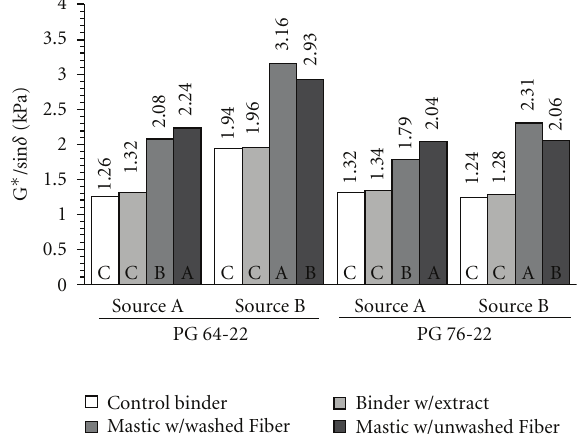
Figure 4: Phase angle ( δ ) results from dynamic the shear rheometer (DSR). The test temperature was 64 ◦ C for the PG 64–22 binders and 76 ◦ C for the PG 76–22 binders.